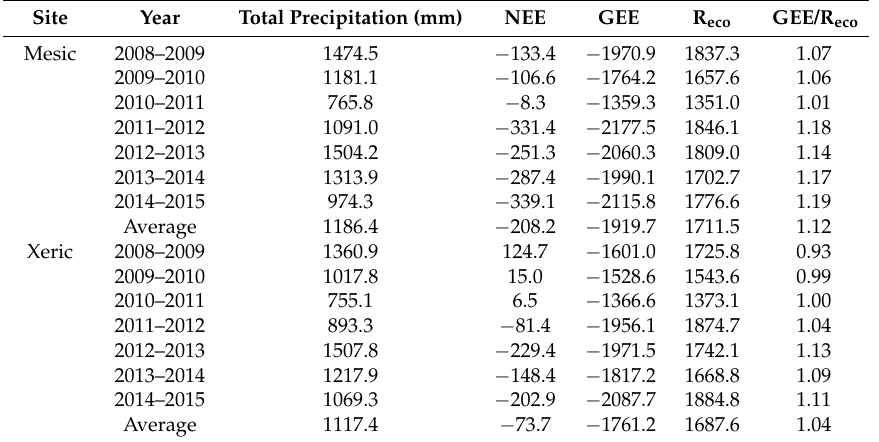
Table 1. Annual precipitation (mm), Net Ecosystem Exchange of Carbon (NEE, g C m 2 ¨ year ´ 1 ), Gross Ecosystem Exchange of Carbon (GEE), Ecosystem Respiration (R eco ), Ratio of GEE to R eco